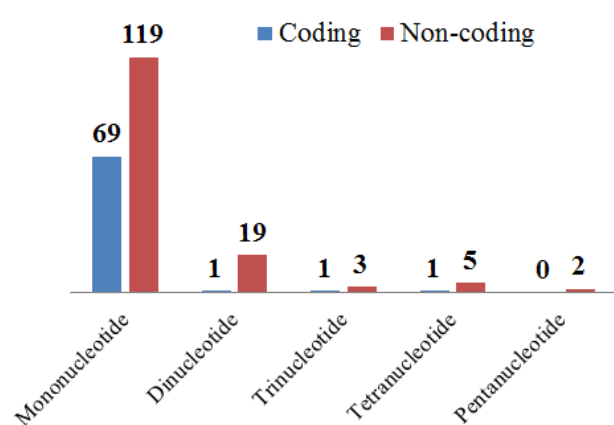
Figure 8. SSR type distribution between coding and non-coding regions. Y-axis represents the number of SSRs.